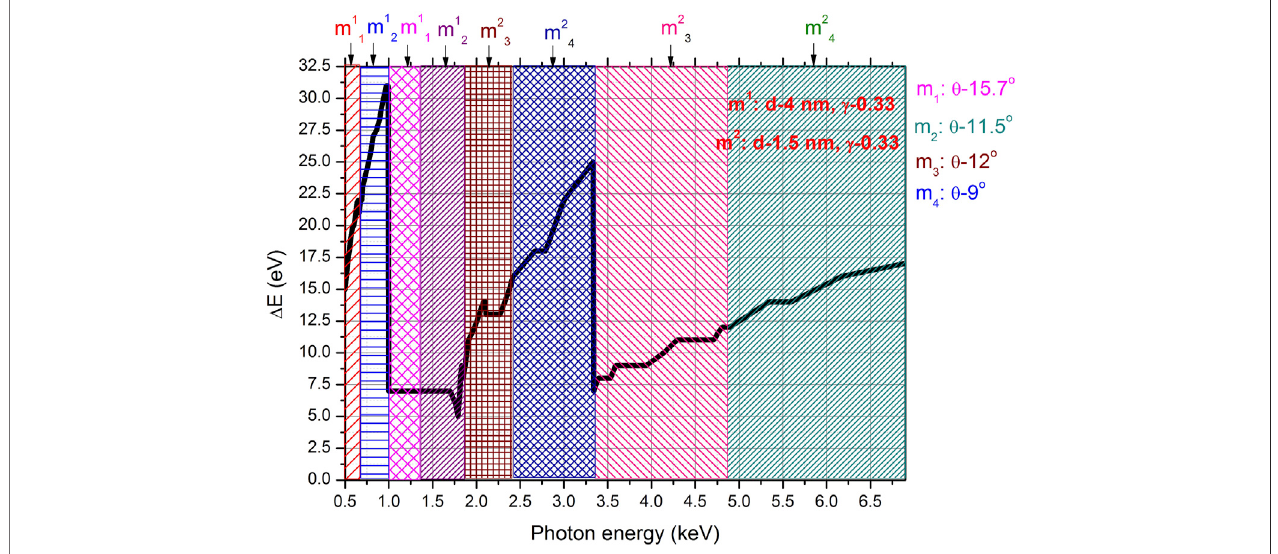
FIGURE 4 | Estimated spectral resolution of the instrument combined in all four channels.Each channel has the fi rst and second Bragg orders. m # represents two multi-layermirrorswithdifferentcoatingspeci fi cations.m #